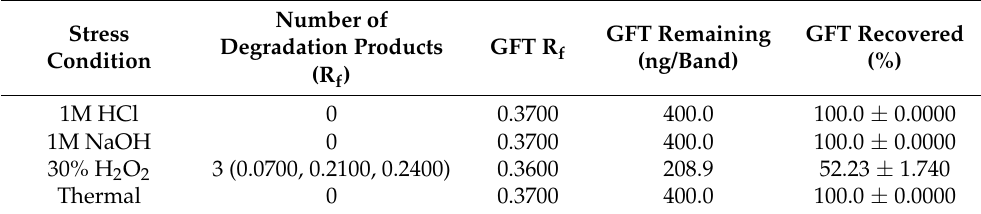
Table 6. Results of forced-degradation assessment of GFT at various stress conditions for the routine HPTLC method (mean ± SD; n =